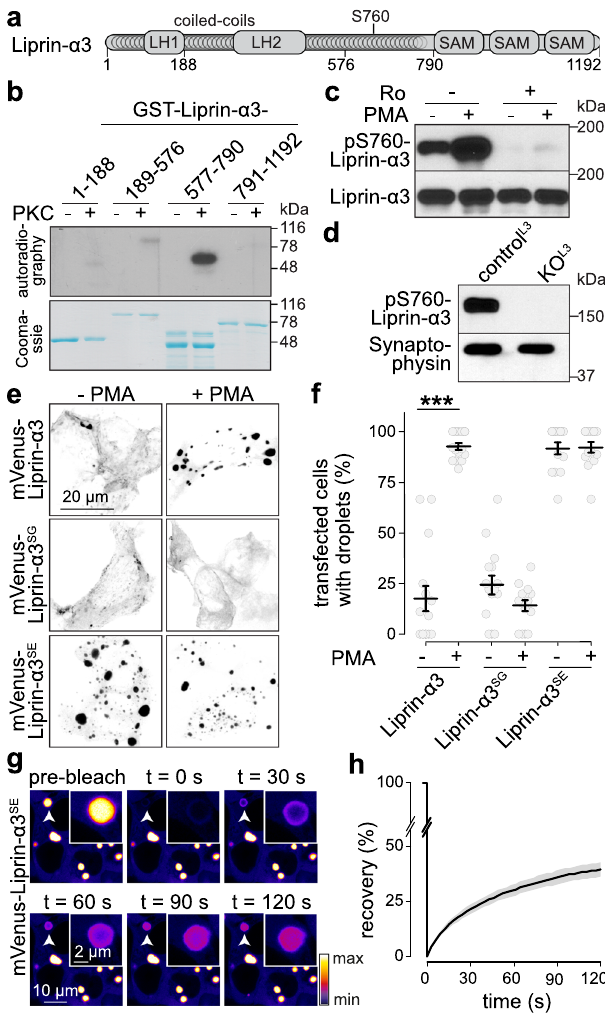
not detected in Liprin- α 3 knockout neuronal cultures (Fig. 2d), con fi rming antibody speci fi city. Together, these experiments establish that PKC phosphorylates Liprin- α 3 at S760, but likely not at S764. It is possible that the S764 mutation abolishes S760 phosphorylation (and Liprin- α 3 phase separation) indirectly, as the